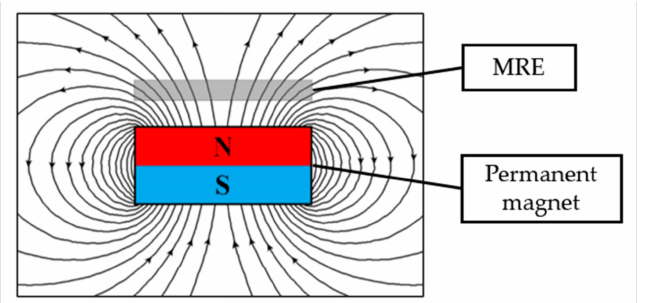
Figure 1. The schematic diagram of MRE for which induced magnetic flux densities would drive the magnetic particles (CIPs) in the MRE to align along the magnetic lines during